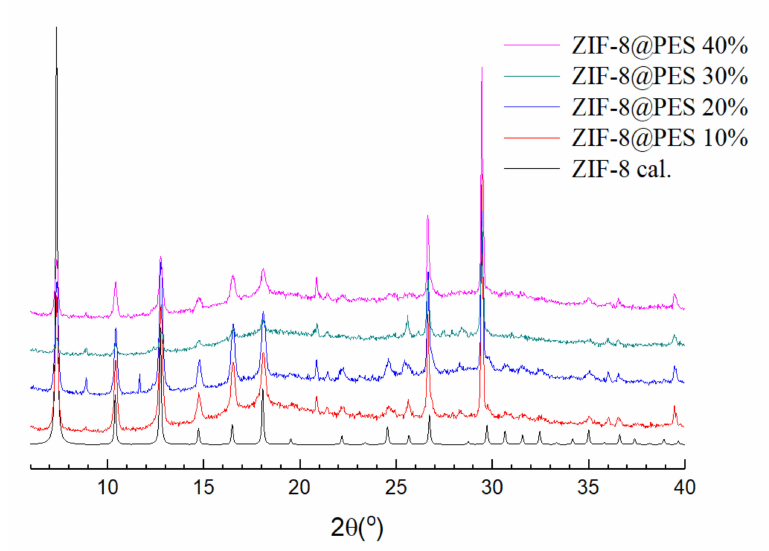
Figure 5. PXRD pattern of prepared mixed matrix membranes (MMMs) at di ff erent mixing ratios of